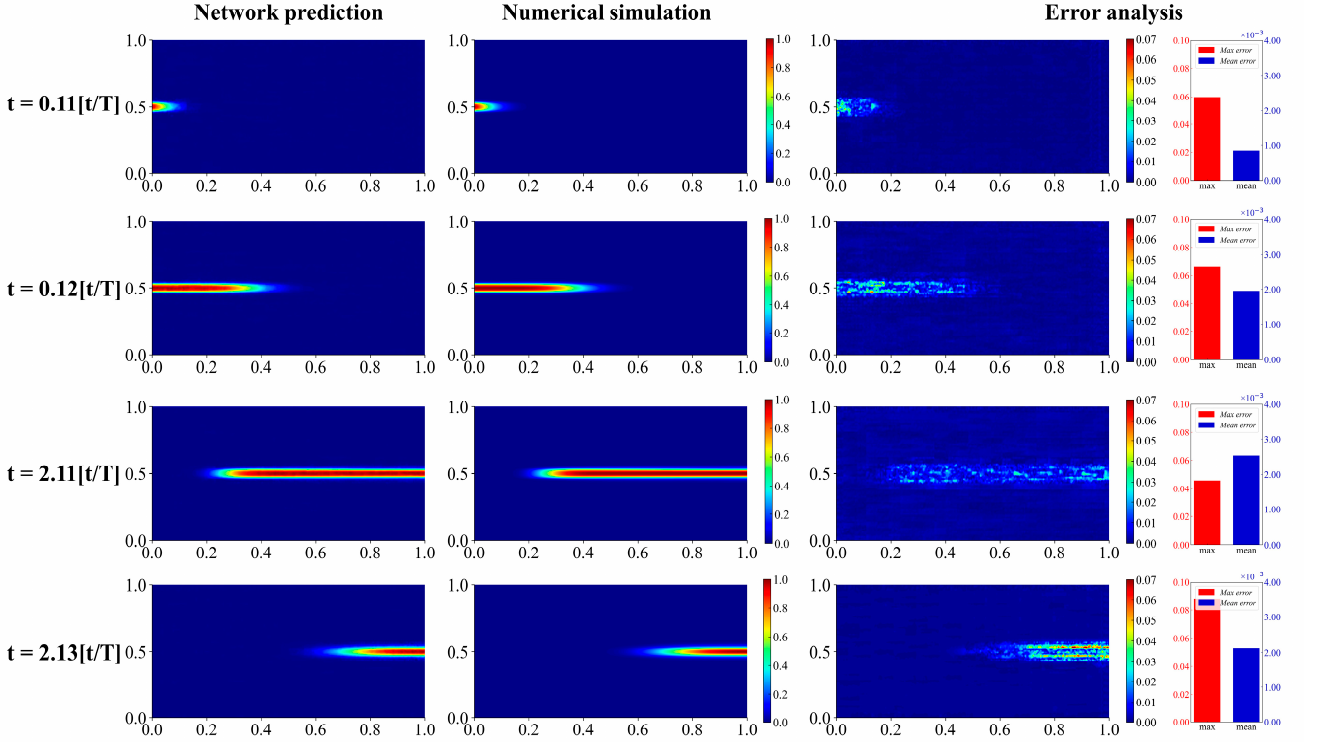
Figure 5. Drug concentration field and error distribution at four different times for the straight blood vessel with a drug injection on the central axis.